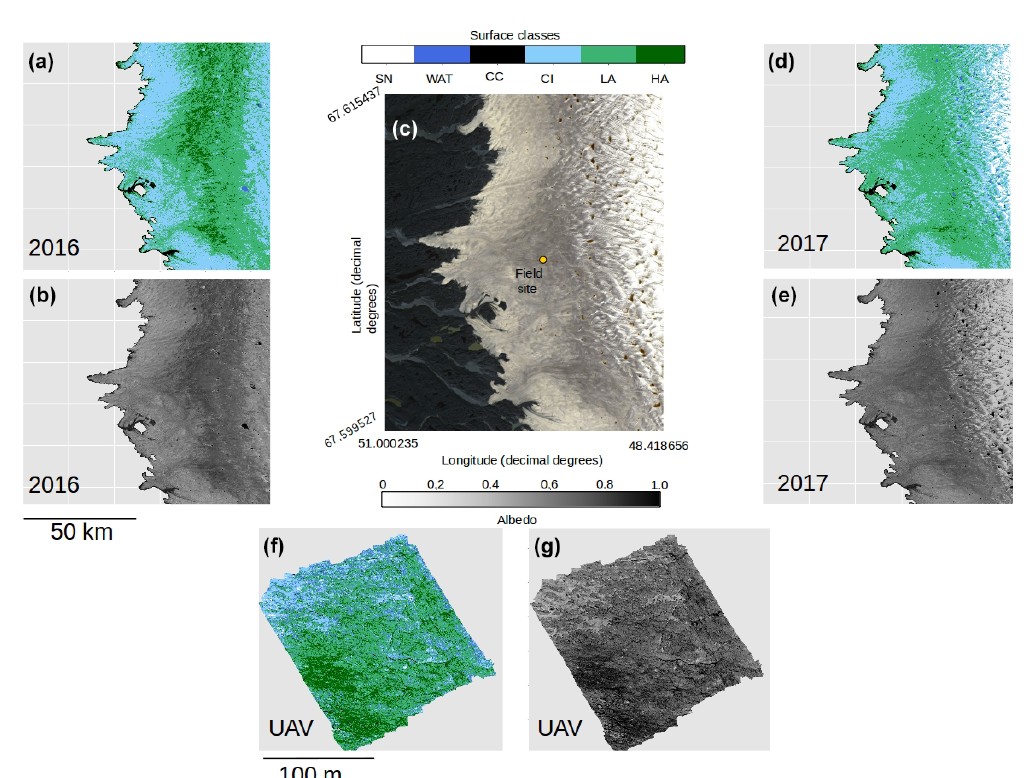
Figure 7. (a) Classified map of the area shown in (c) for 2016. (b) Broadband albedo map of the area shown in (c) for 2016. (c) RGB “true colour” image showing the Sentinel-2 tile covering our field site in the Kangerlussuaq area. (d) Classified map of the area shown in (c) for 2017. (e) Broadband albedo map of the area shown in (c) for 2017. (f) Classified map of a 200 × 200m area at the field site marked in (c) imaged using a UAV-mounted multispectral camera. (g) Broadband albedo map of a 200 × 200m area at the field site marked in (c) imaged using a UAV-mounted multispectral camera. Panels (a–e) all have pixel resolution of 20m and use the base geographic coordinate reference system WGS84 and the Universal Tranvserse Mercator Projection (UTM) 22N. The scale bar beneath (b) is common to (a, b, d, e) , and the scale bar beneath (f) is common to (f) and (g)